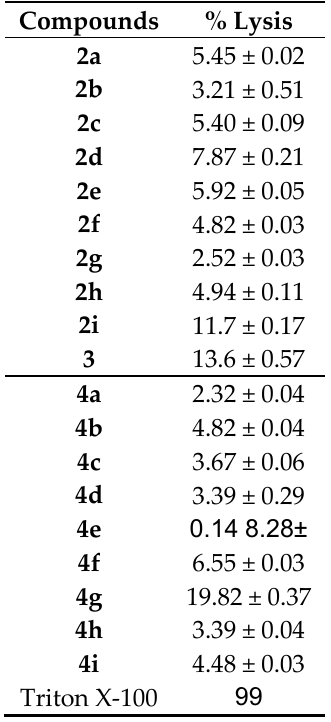
Table 7. Heamolytic assay of the compounds ( 2a – 2i , 3 and 4a – 4i ) at a concentration of 50